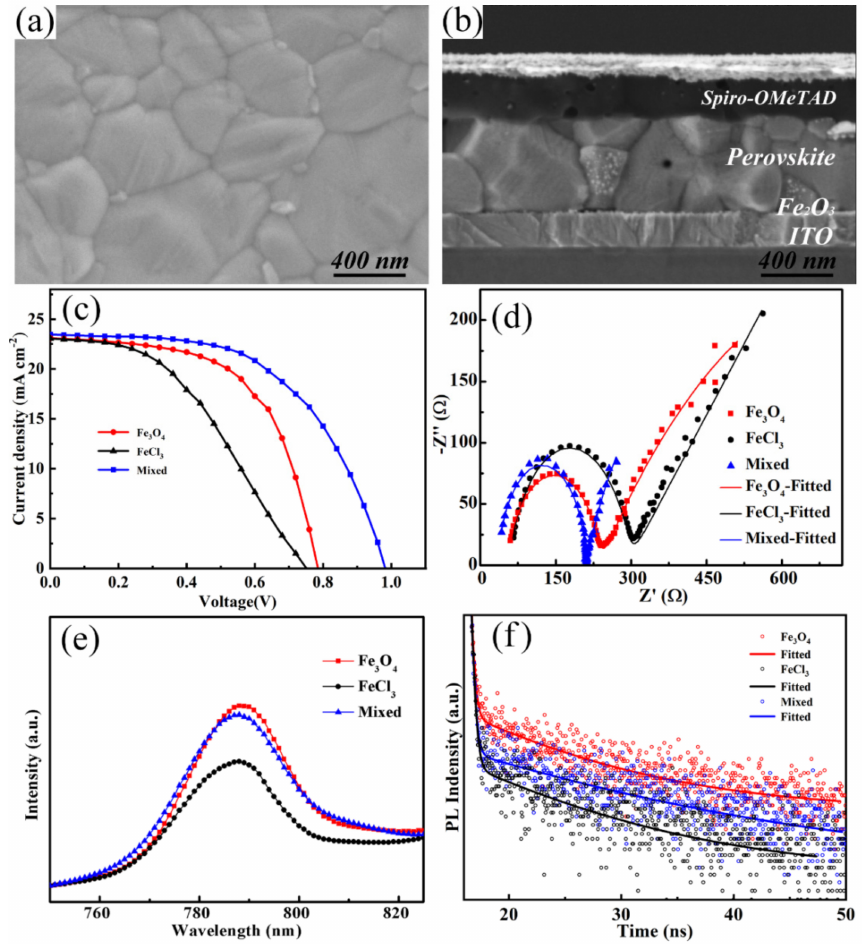
Figure 3. ( a ) Top-view SEM image of the perovskite layer. ( b ) Cross-sectional SEM image of the entire structure. ( c ) J-V curves of PSCs based on Fe 2 O 3 ETLs prepared by different methods. ( d ) Nyquist plots of PSCs based on the Fe 2 O 3 ETLs prepared by different methods. ( e ) PL spectra, ( f ) TRPL spectra of perovskite based on Fe 2 O 3 films prepared by different